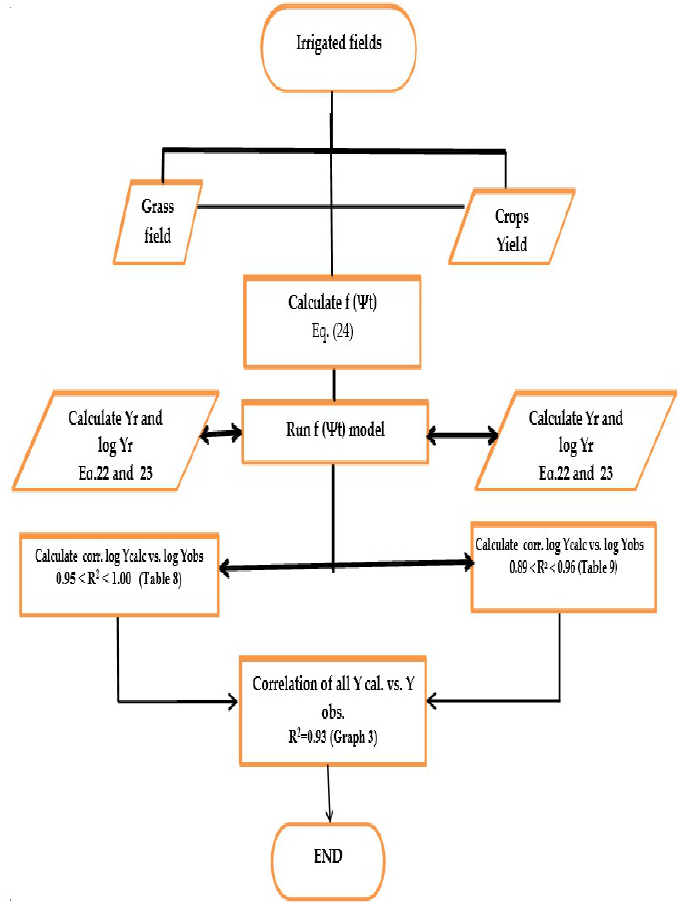
Figure 6. Flowchart describing independent validation of Equations (1) and (2) by processing data collected from experi- ments on golf courses.